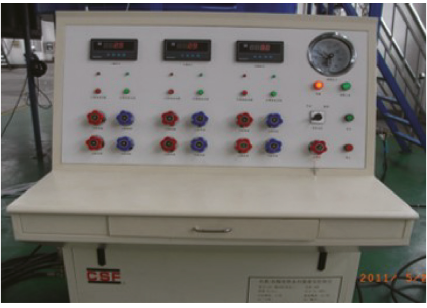
Figure 2: High-precision static servo-hydraulic control system.